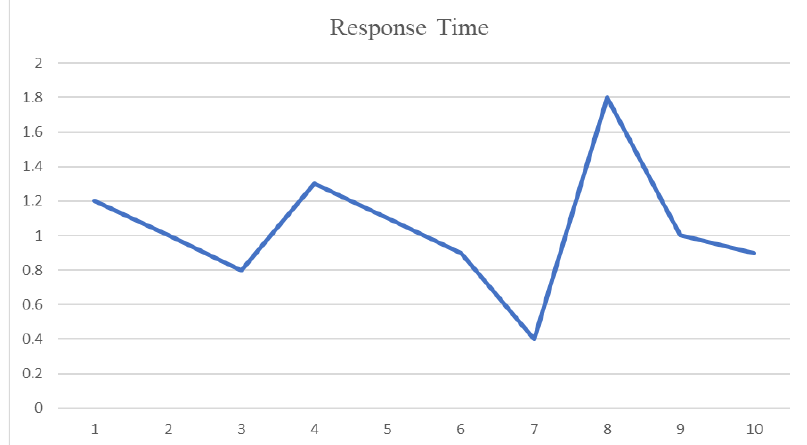
Figure 10. Graph showing the response time of the wheelchair system to movement